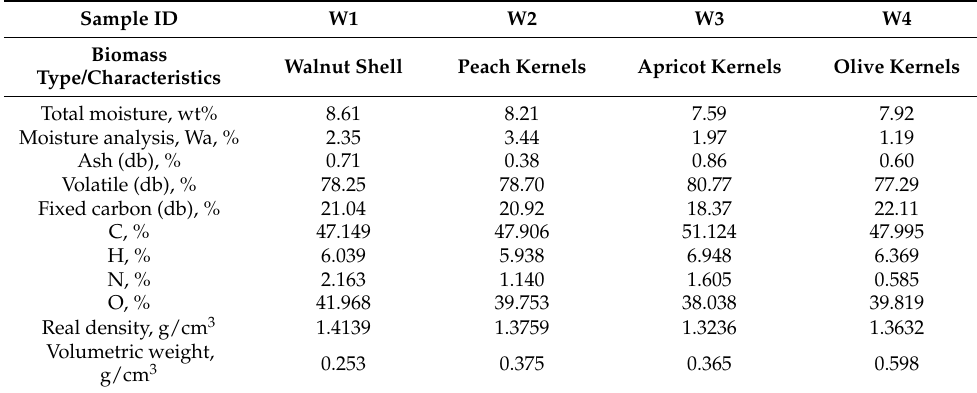
Table 1. Physical–chemical characteristics of biomass